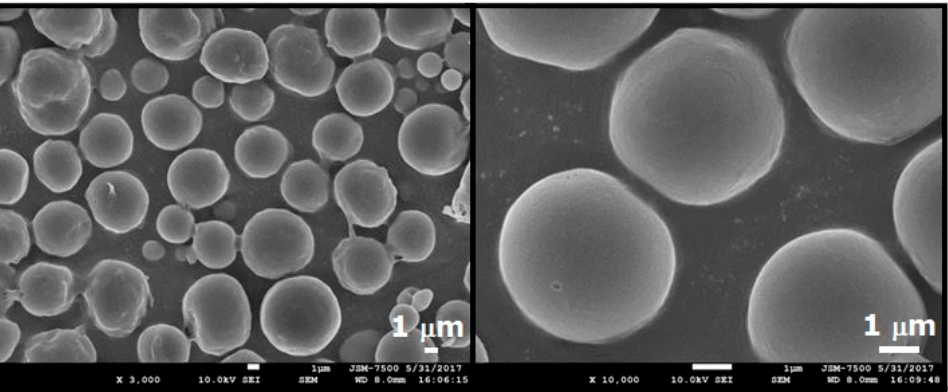
Figure 5. Drug-eluting 75:25 PLGA nano/microparticles (DCM was used as the solvent).